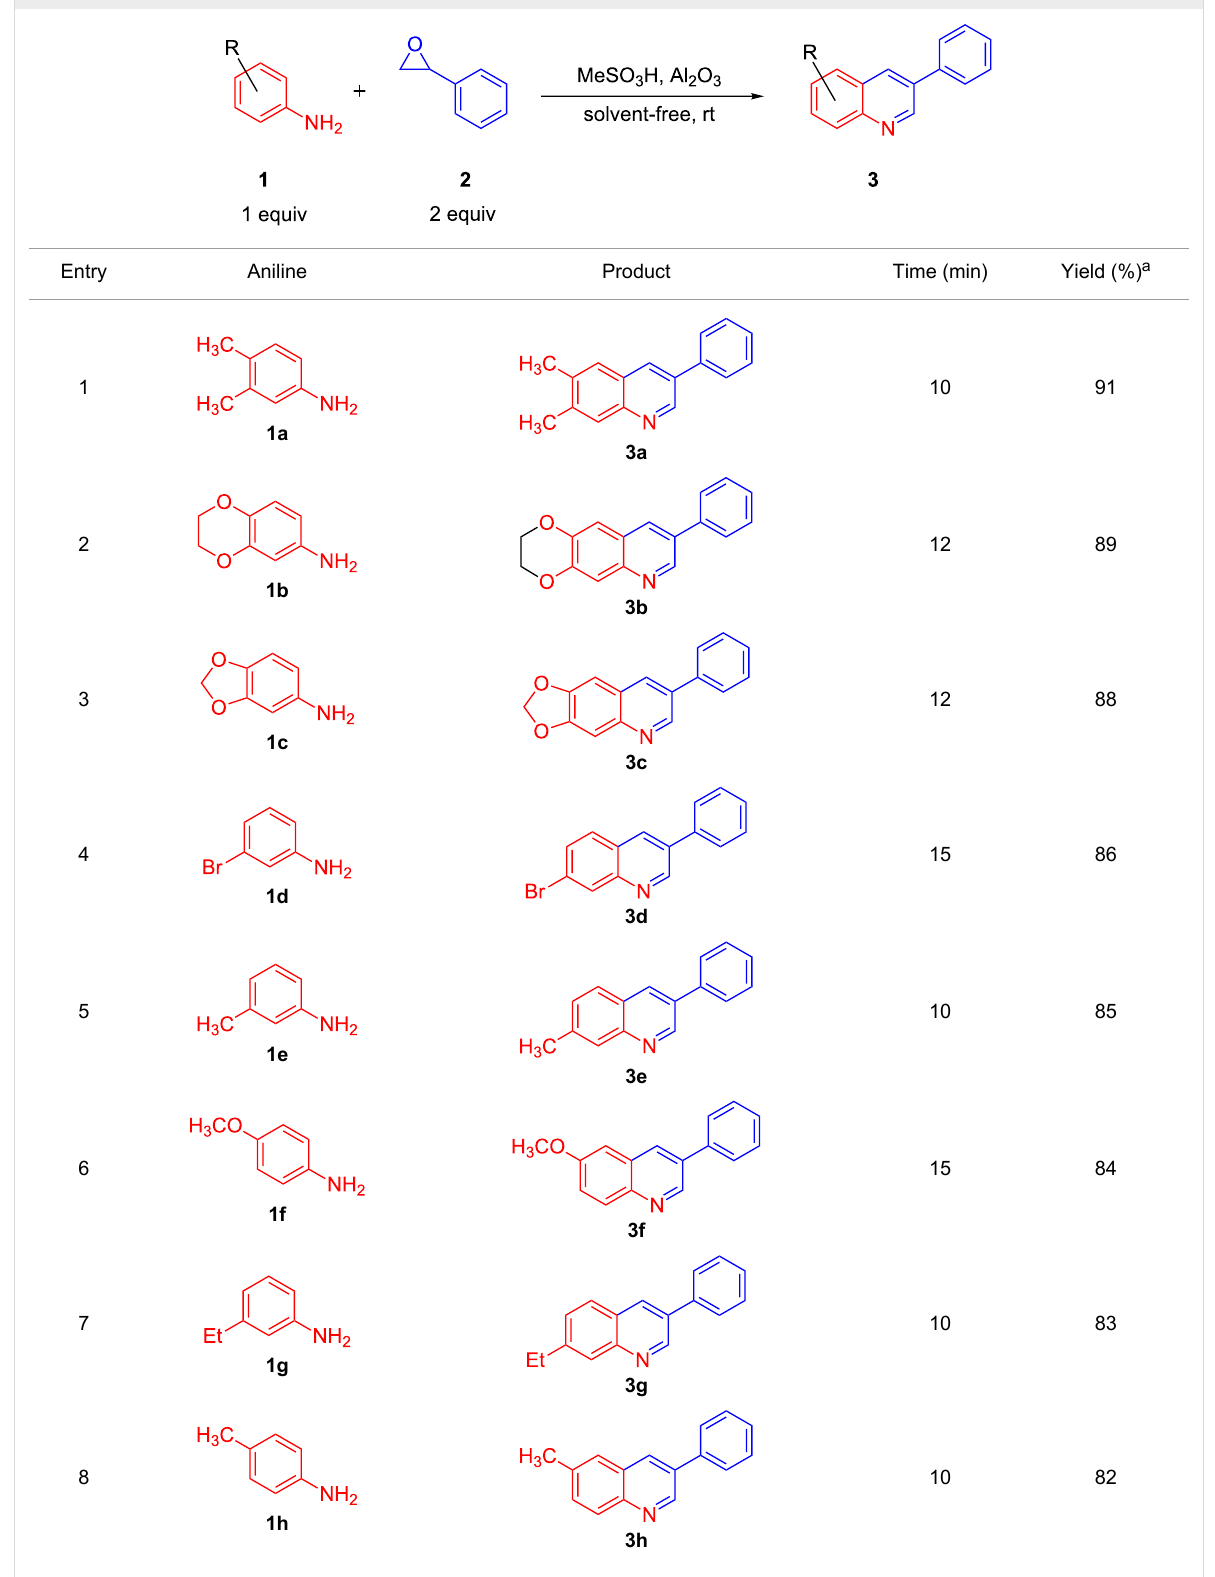
Table 2: One-pot synthesis of 3-arylquinolines from the reaction of different anilines (1.0 mmol) with styrene oxide (2.0 mmol) in the presence of Al 2 O 3 and MeSO 3 H at room temperature under solvent-free